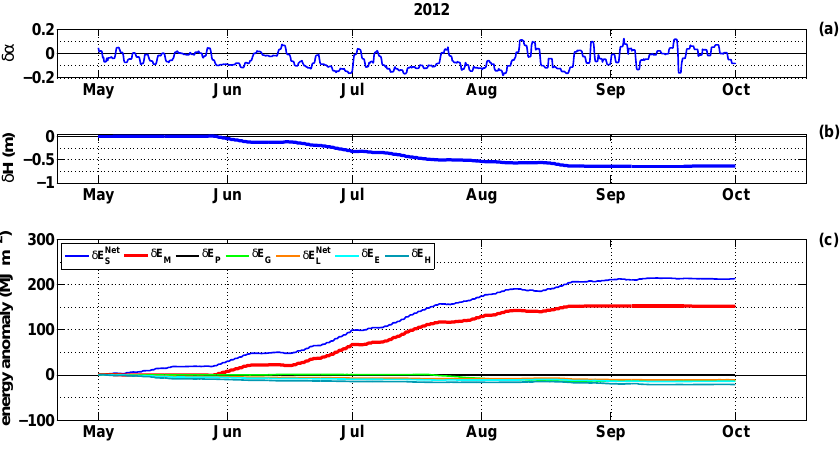
Figure 10. (a) Albedo anomaly in 2012 measured by KAN_U for the months May–September; (b) simulated relative surface height anomaly; (c) simulated cumulative energy anomalies for all contributing